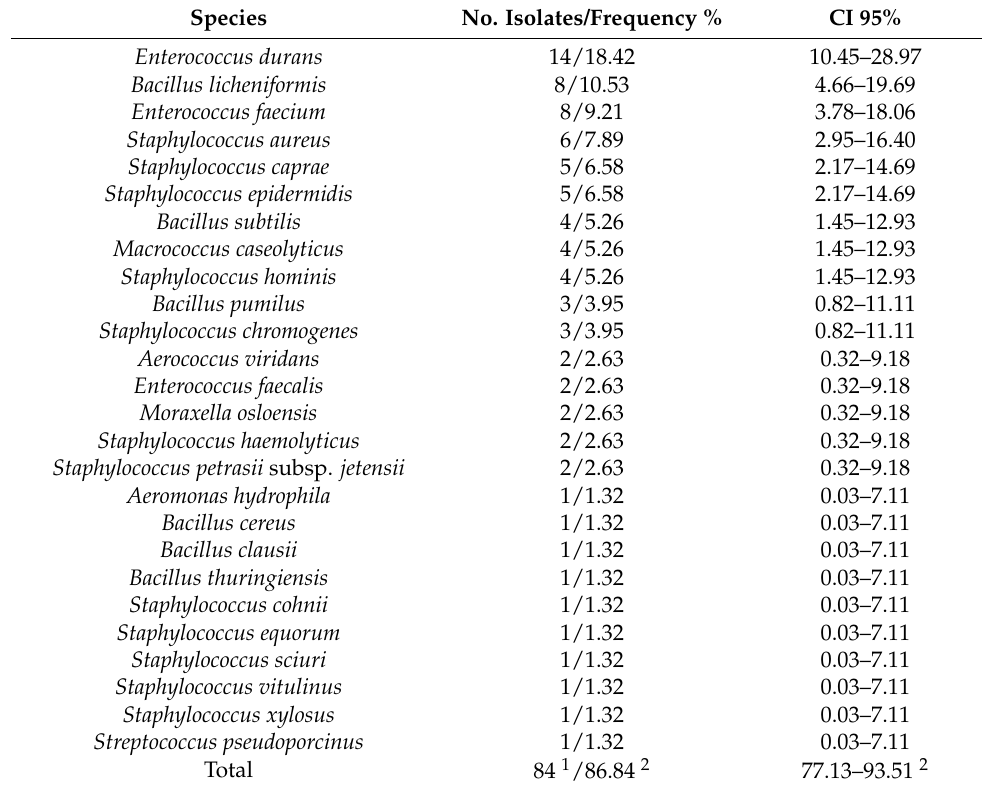
Table 1. The frequency of bacterial species identified by BLAST analysis of 16S rRNA gene sequence in 76 composite mid-lactation milk samples from Carpathian goats without signs of clinical mastitis in